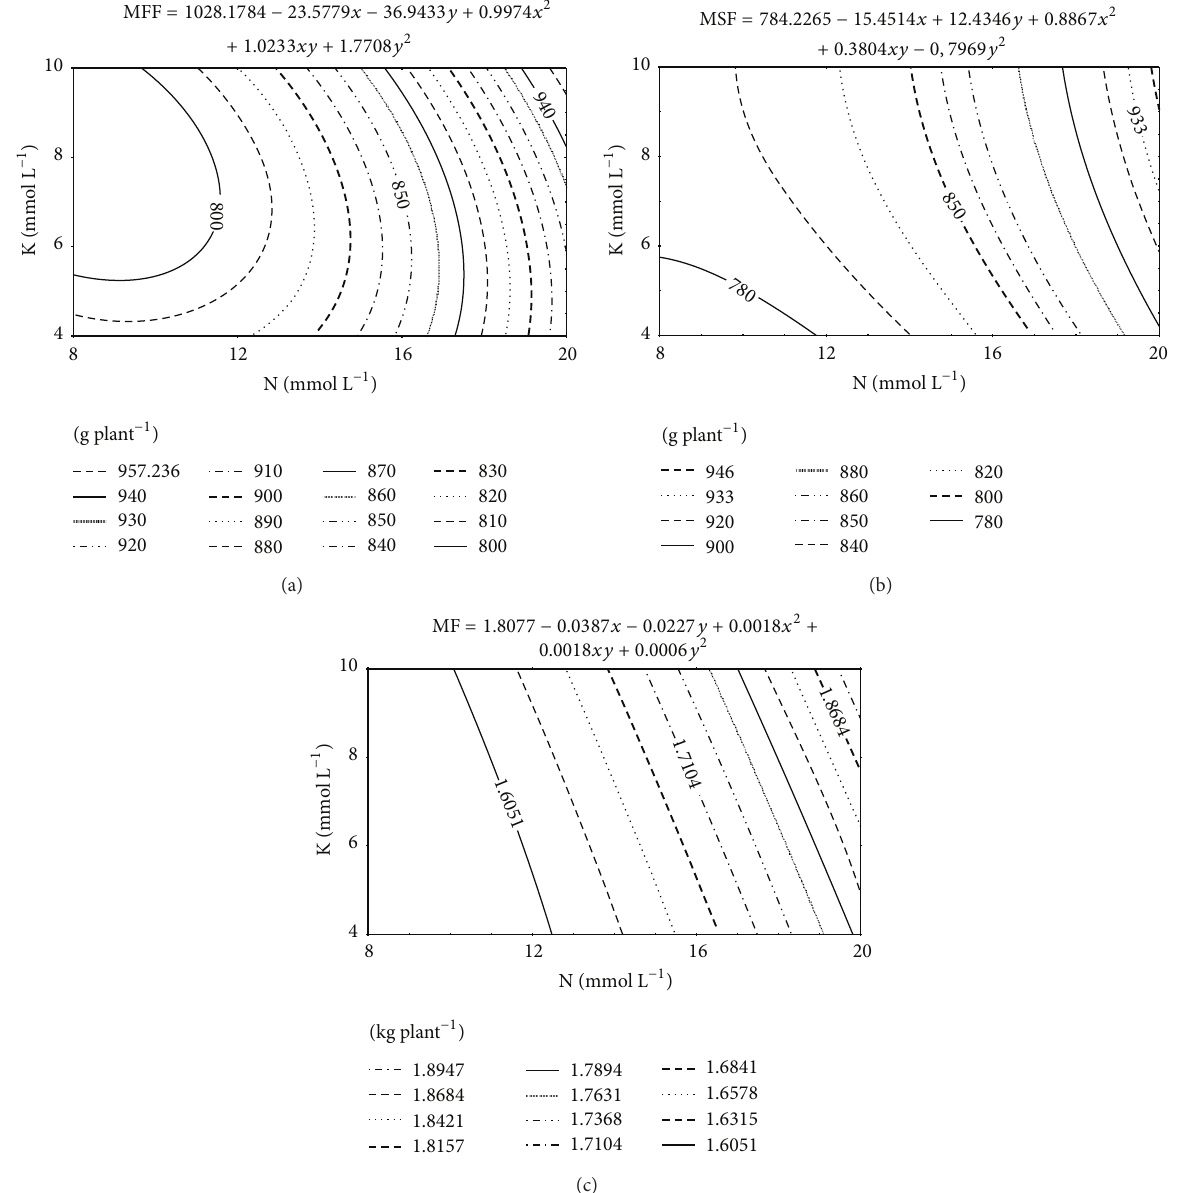
Figure 7: Mass of the first fruit (MFF) (a), of the second fruit (MSF) (b), and of fruits (MF) (c) as influenced by the concentrations of N and K in the nutrients